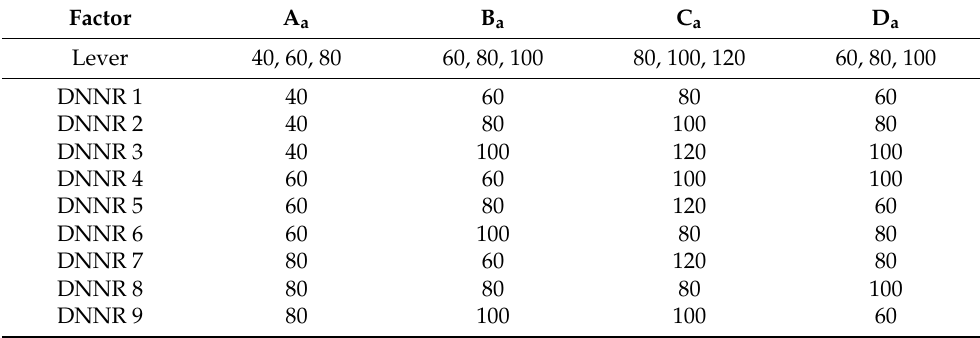
Table 3. The results of an orthogonal design experiment for the hyperparameter of the DNNR model.